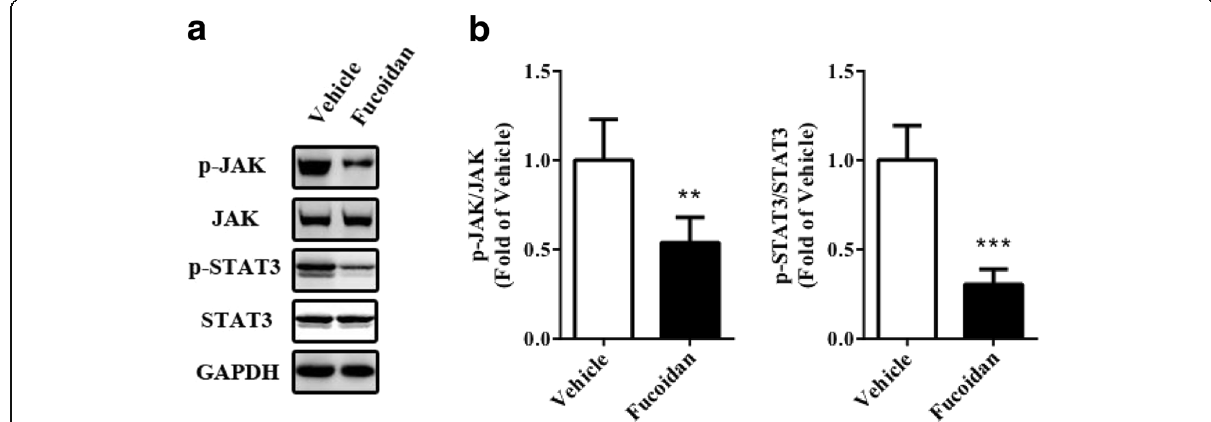
Fig. 5 Fucoidan reduced phosphorylation of JAK and STAT3. Tumor tissue from prostate cancer xenograft was isolated and homogenized for Western blot. a Representative blot. b Statistical analysis of ( a ). GAPDH was used as a loading control. ** P < 0.01 vs. vehicle group, *** P < 0.001 vs. vehicle group. N = 6 for eachgroup